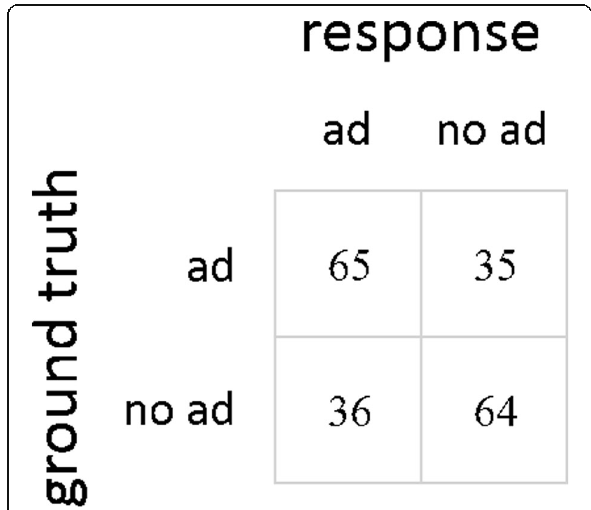
Fig. 7 Results of the ad-detection task, in percent of responses. Diagonal values indicate correct